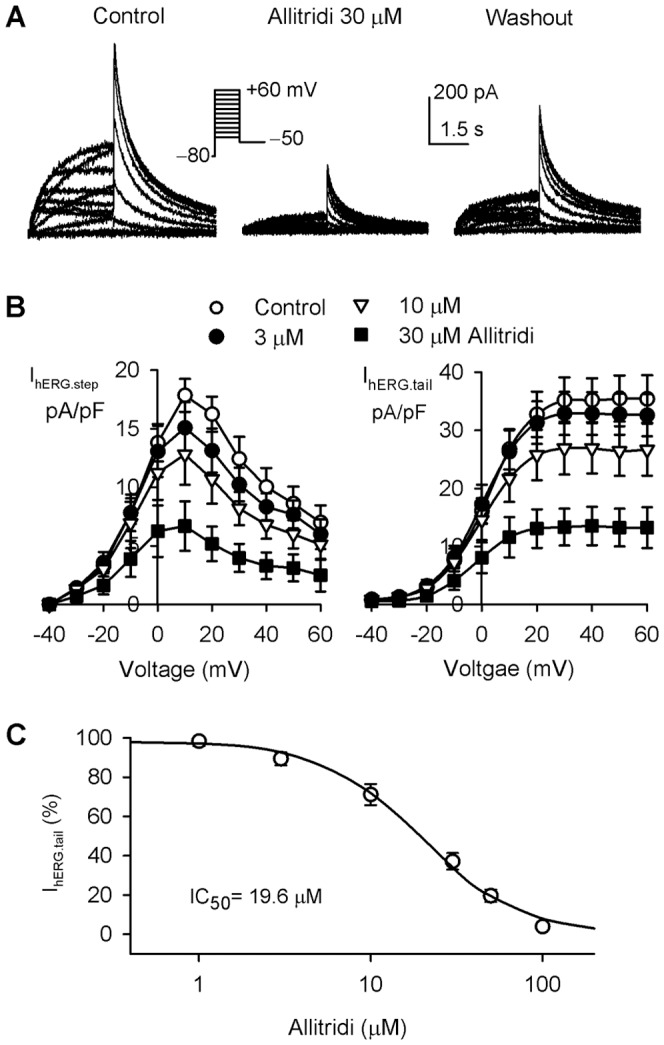
Inhibition of hERG channels by allitridi.
A. Voltage-dependent hERG current recorded in a representative cell with the voltage protocol as shown in the inset, in the absence and presence of 30 µM allitridi. B. Current-voltage (I-V) relationships of hERG step current (IhERG.step) and tail current (IhERG.tail) in the absence and presence of 3, 10, and 30 µM allitridi (n = 7, P<0.05 or P<0.01 with 30 and 100 µM allitridi vs. control at 0 or +10 to +60 mV). C. Concentration-response relationship curve of allitridi inhibiting hERG tail current was fitted to a Hill equation (n = 6–8 experiments for each concentration.